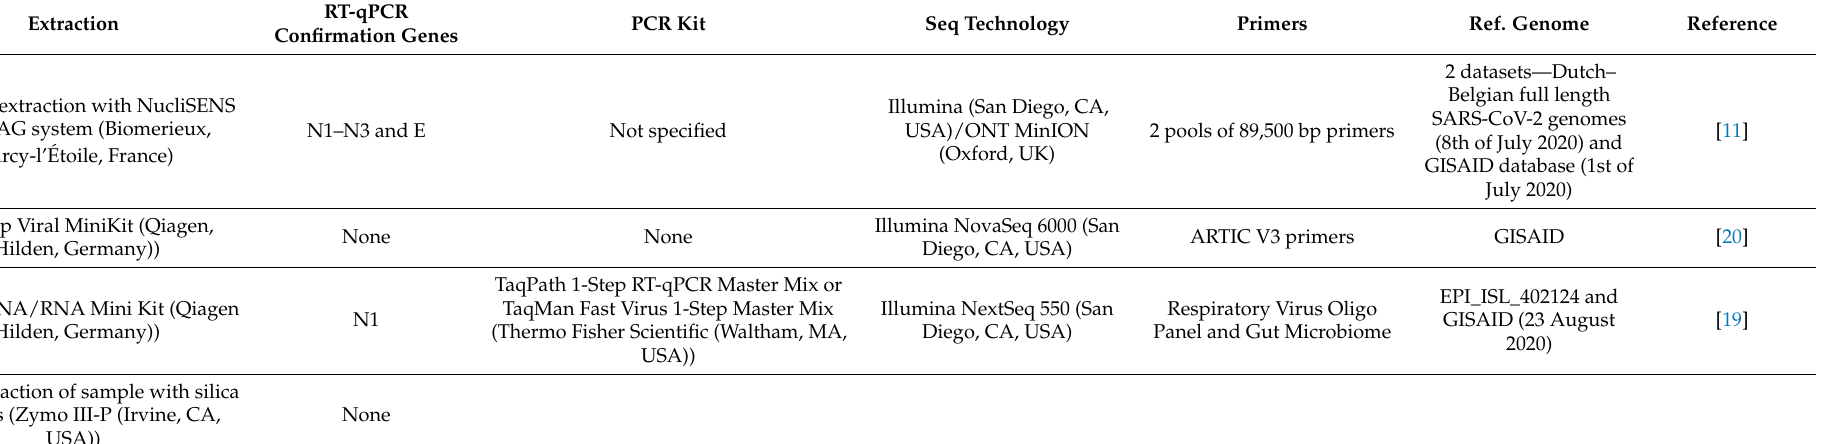
Table 1. Literature review. Information about sampling, pretreatment, extraction of RNA, RT-qPCR, and sequencing technology for the detection SARS-CoV-2 in